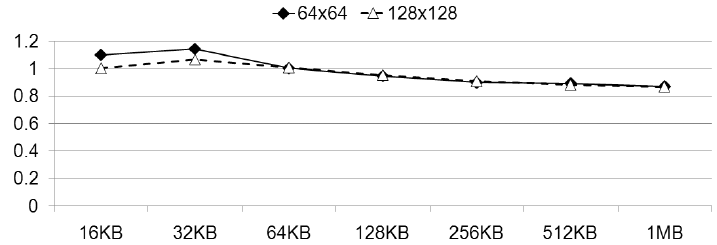
Figure 19. Speed-up of PPE TL over PPE VECTOR with varying data size.